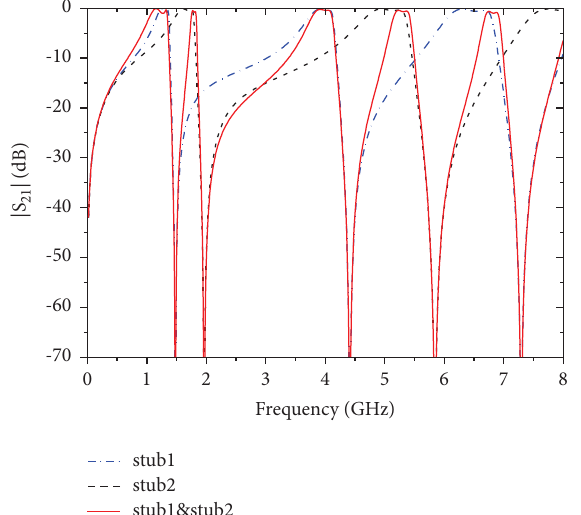
Figure 11: *e | S 11 | of the proposed BPF composed of stub1 and stub2.